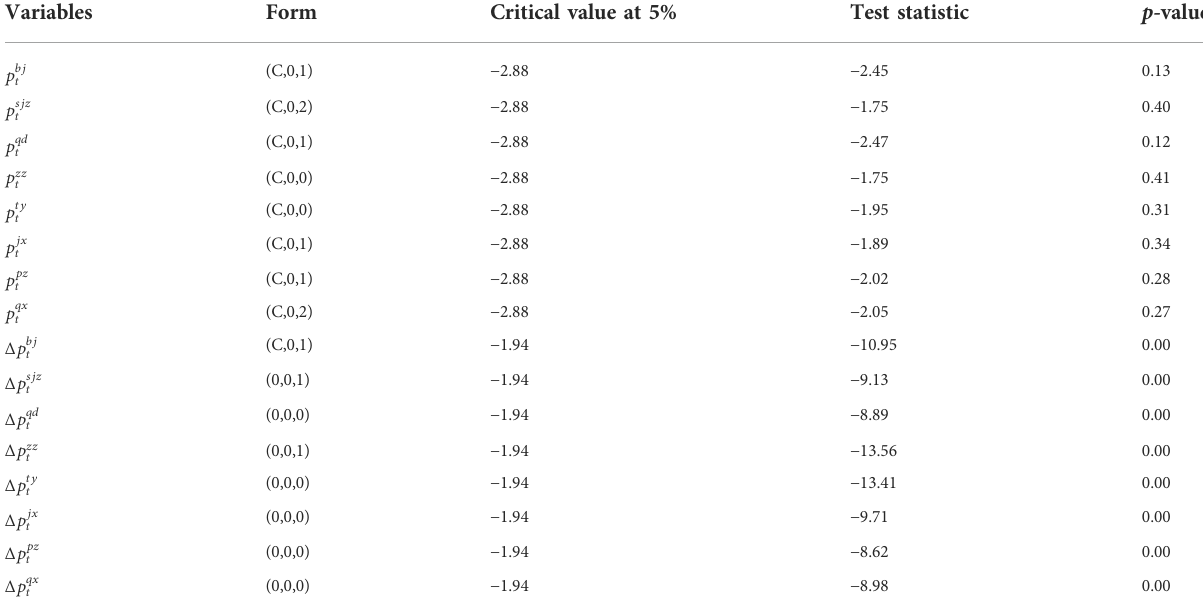
TABLE 2 Results of the ADF unit root test for price series.